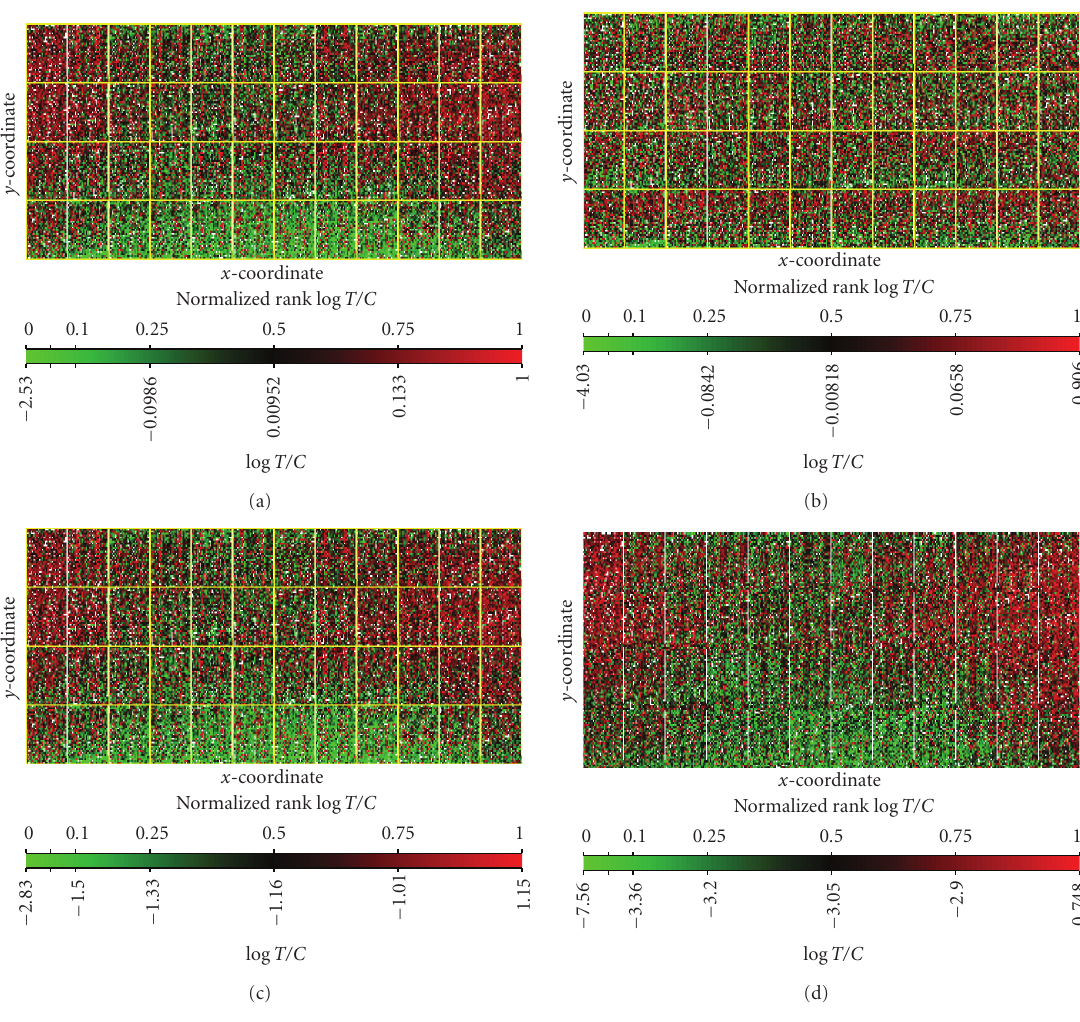
Figure 12: Other methods: the final log T/C values from other normalizing methods, namely, (a) global median subtraction, (b) grid loess normalization, (c) quantile normalization, and (d) background subtraction. From a visual inspection, there appear to be spatial artifacts that are not removed by these normalization methods. Table 3: Table comparing the percentage of P values less than .05 on the X chromosome. From this metric, we see that the “SmoothArray” procedure performs favorably compared to the grid loess and global median normalization methods. Raw “SmoothArray” Grid loess Quantile normalization Global median 100% 93% 90% 100% 89%